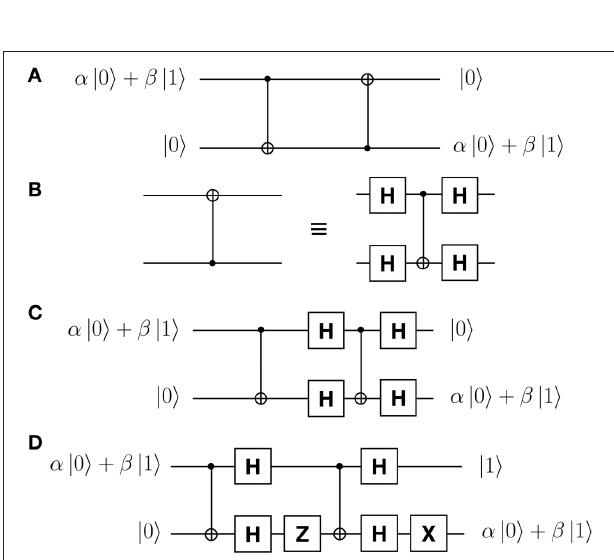
FIGURE 5 | Network for quantum state transfer. (A) , By means of two CNOT gates a qubit α 0 1 can be transferred from one side (top) to the β | i + | i other (bottom). Our counterfactual CNOT gate has Bob’s as the control qubit, which is a problem since in this network the control qubits of the two CNOT gates are on opposite sides. (B) , By means of four Hadamard gates the control and target qubits of any CNOT gate can be interchanged. (C) Applying (B) to (A) , the control qubits of both CNOT gates are now on the same side, Bob’s. This network forms the basis of our protocol for counterfactually transporting an unknown qubit. (D) , In case of a Z-gate before the right hand side CNOT, we need an X-gate at the end in order for the state α 0 1 to β | i + | i be correctly transferred. This network is relevant to one of the two possible paths for Alice’s exiting photon from the Dual CQZE setup of Figure 3B